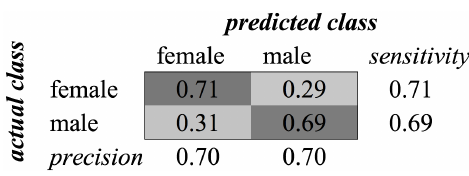
Figure A6. KHMM confusion matrix of category Gender for MFCC feature type.